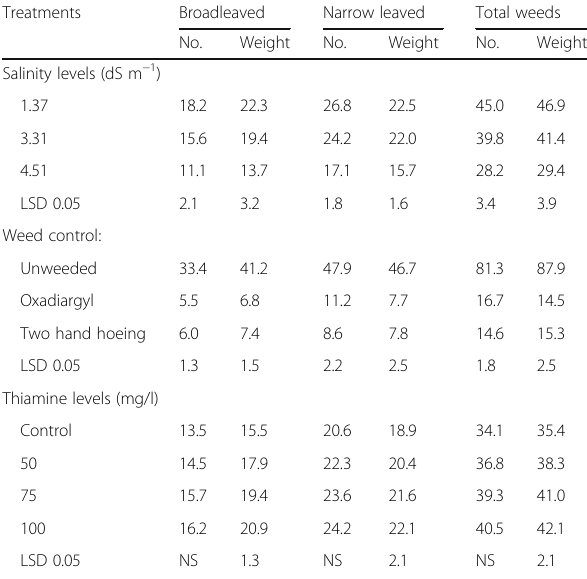
Table 2 Effect of weed control and thiamine levels on number and dry weight (g/m 2 ) of faba bean weeds at 60 days from sowing under salinity condition (combined analysis of two seasons) Treatments Broadleaved Narrow leaved Total